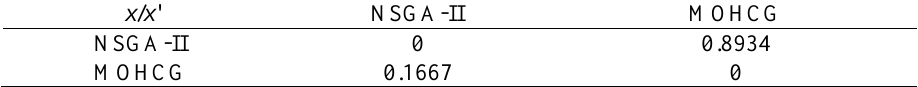
Table 10 . Coverage of two sets average value for medium/large sized problems